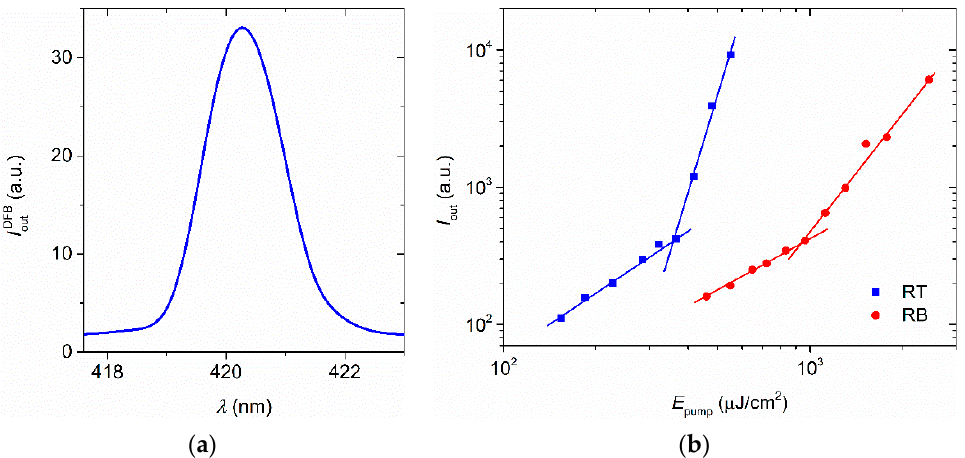
Figure 9. ( a ) Laser spectrum of a DFB device based on TPD (3 wt%). ( b ) Output intensity, I out , as a function of pump energy density, E pump , for two DFBs lasers based on TPD (3 wt%) with different configuration: RT (blue) and RB (red). Threshold energy densities were calculated from this graph as the energy density at which a drastic change in the slope curve occurs.